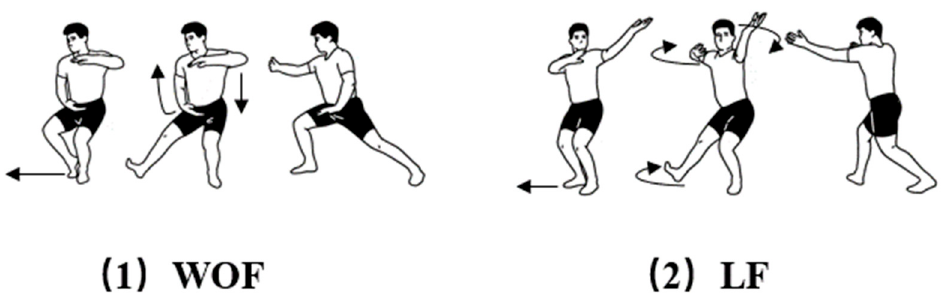
Figure 1. Illustration of the Two Progressive Motions of Bafa Wubu of Tai Chi: ( 1 ) WOF, warding off with steps forward; ( 2 ) LF, laying with steps forward.